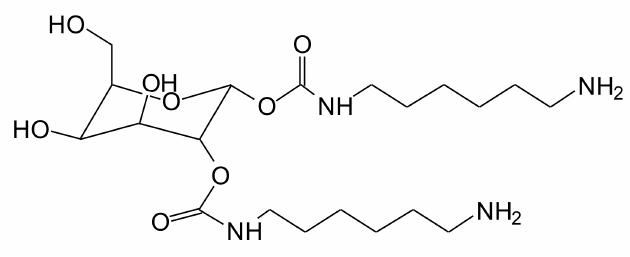
Figure 4. Example of one of the possible glucose diurethane structures.